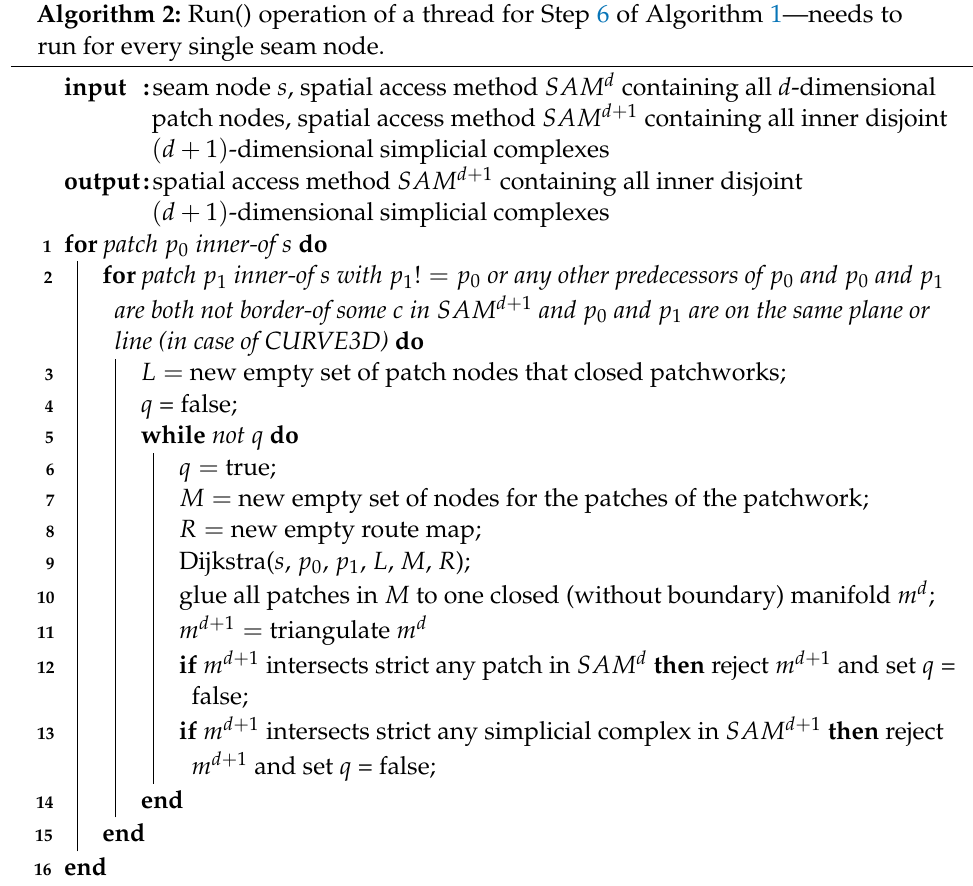
Algorithm 2 of Step 6 of Algorithm 1. Step 7 of Algorithm 1 depends on the number of